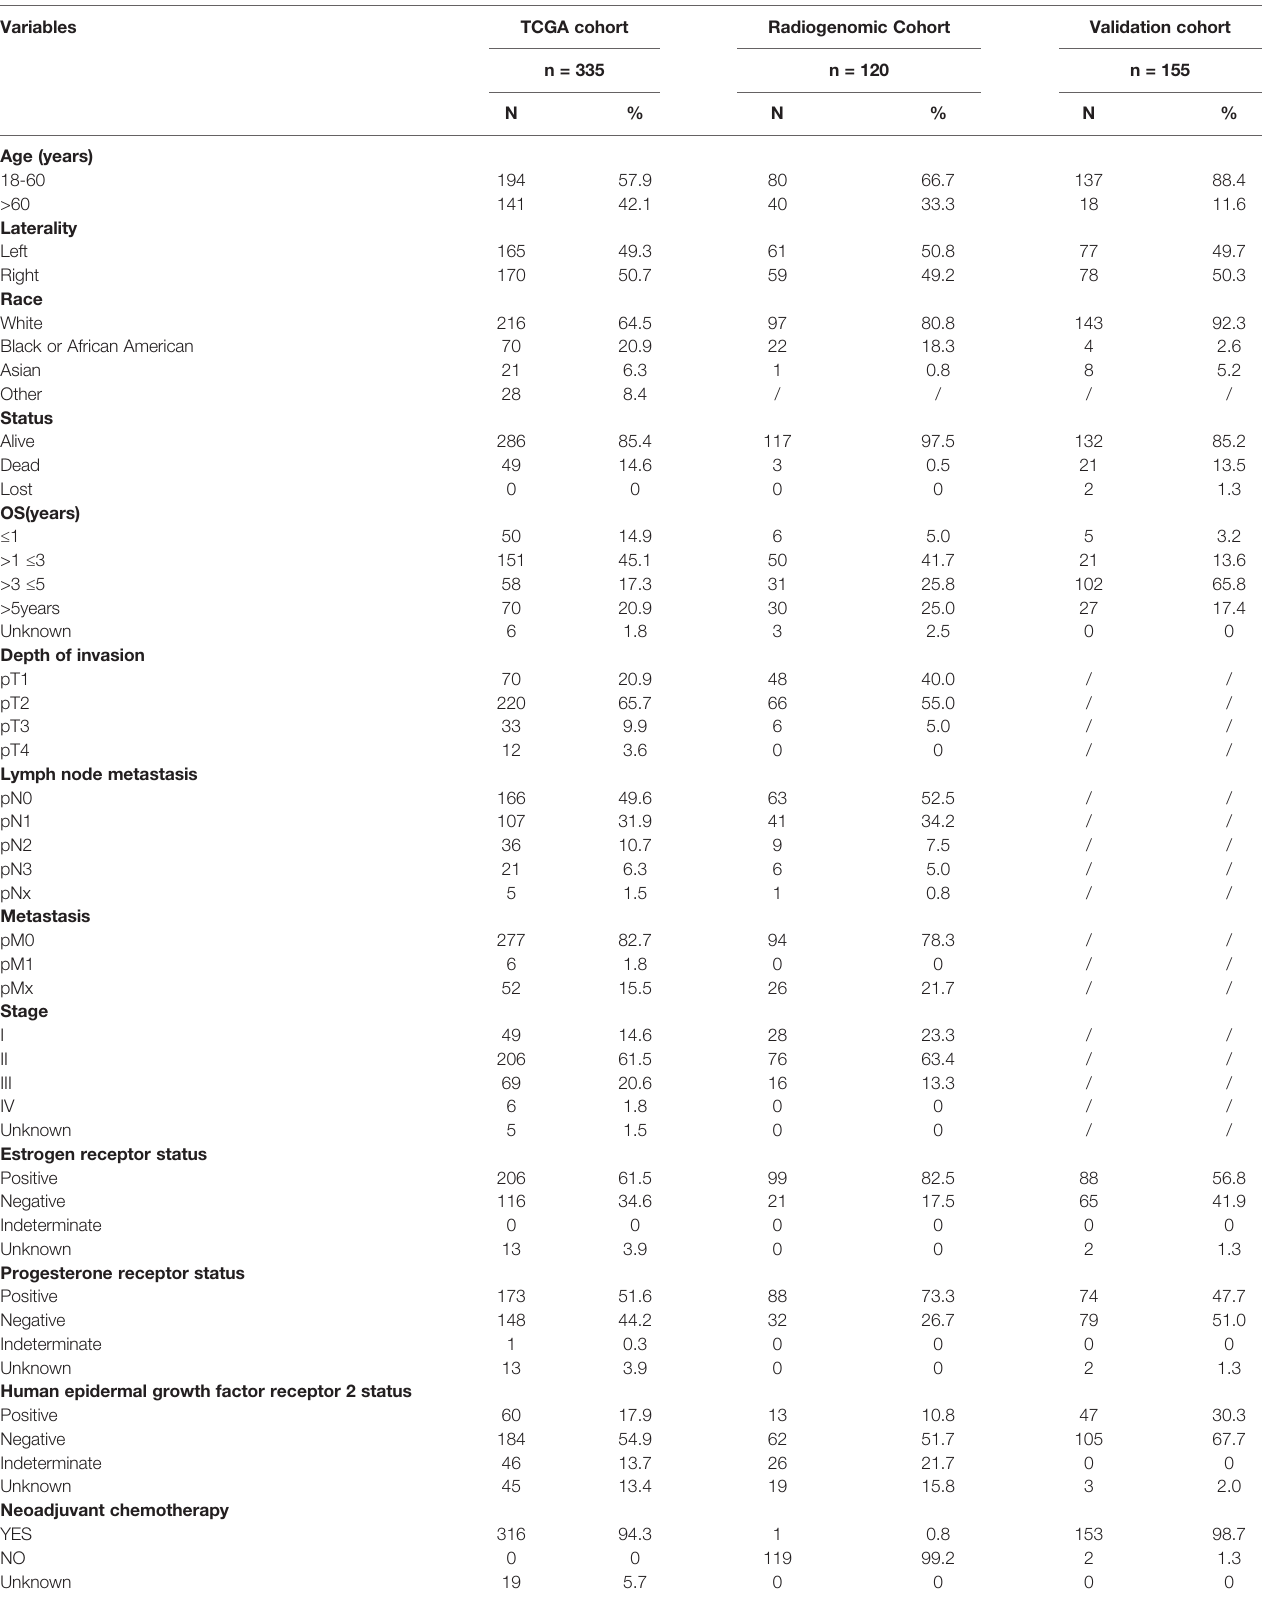
TABLE 1 | Characteristics of patients in the TCGA, radiogenomic, and validation cohorts.